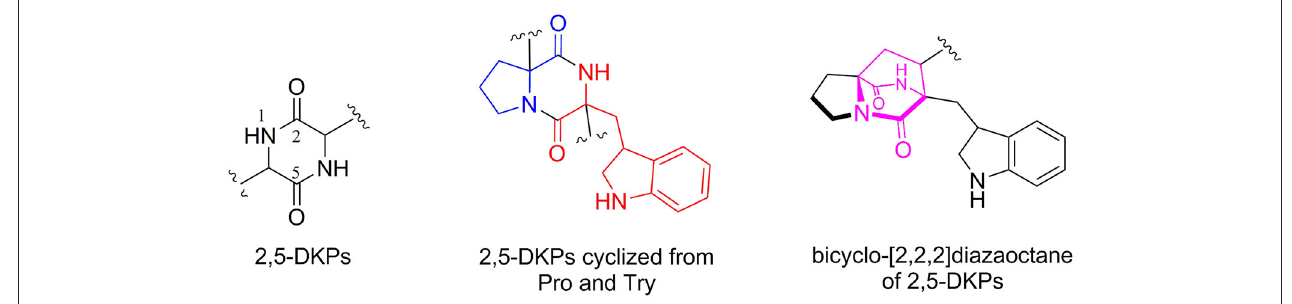
FIGURE 1 | The core structure of 2,5-DKPs and the substructure of common 2,5-DKPs cyclized from Try and Pro.